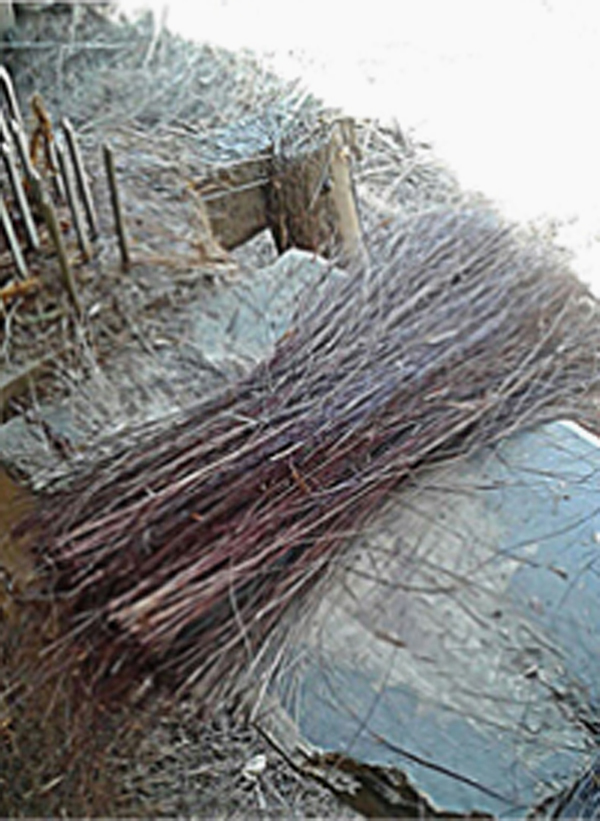
Cutting piassava.